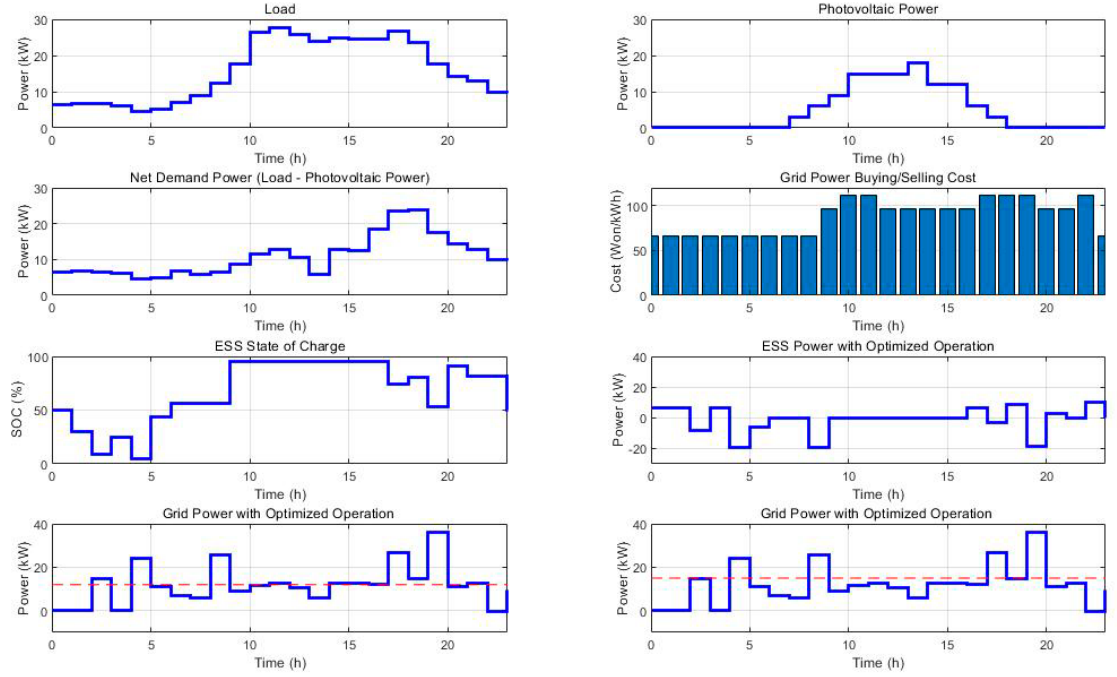
Figure 8. The result of applying peak control. Table 2. The peak control operating conditions.